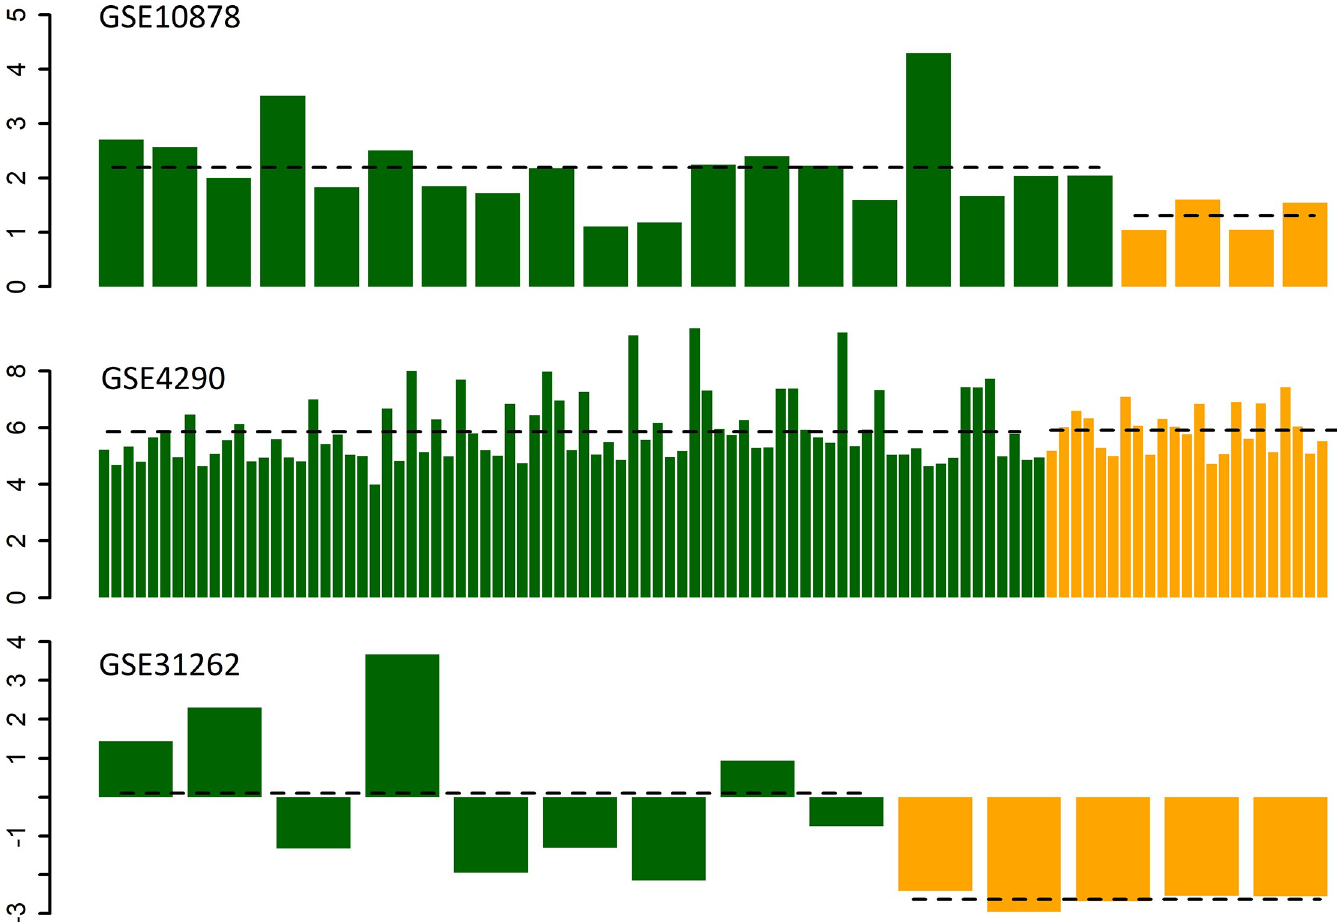
Fig 1. Gene expression of IDO1 in glioblastoma tissue (green) as compared to non-tumor tissue (yellow) with data analyzed from publicly available datasets. Group average expression in the glioblastoma groups and the control groups respectively is represented with the horizontal, dashed black line. On the y-axis log2-transformed fold change is represented, and on the x-axes the expression of IDO1 in the individual samples analyzed is presented. In the GSE4290 data set the Affymetrix Human Genome U133 Plus 2.0 Array platform was used to investigate global gene expression levels in 23 non-tumor brain samples and 77 samples from patients with glioblastoma. In the GSE10878 data set the Agilent-013282 Human Genome CGH Microarray 44B platform was used to compare gene expression in 4 non-tumor samples and 19 samples from patients with glioblastoma. In the GSE31262 data set the ABI Human Genome Survey Microarray Version 2 platform was used to compare gene expression between 5 individual samples of adult neural stem cells and 9 individual samples of glioma stem cells.